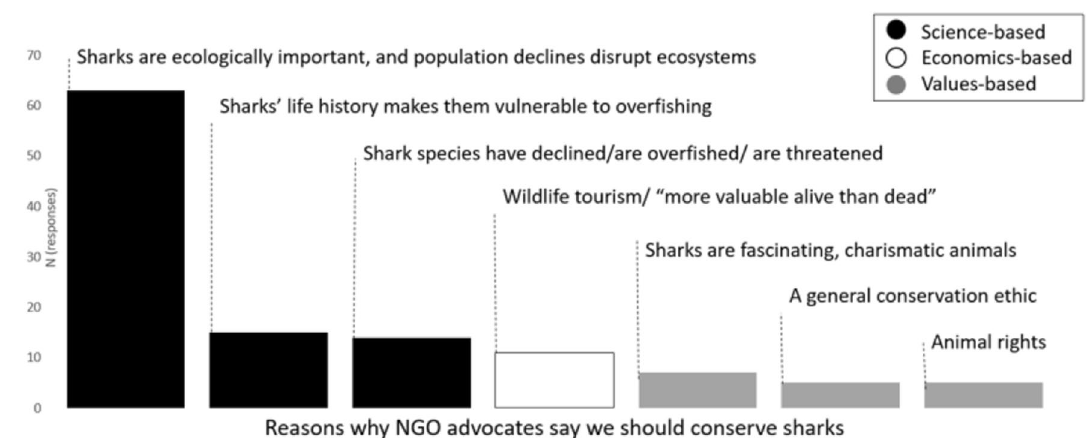
Figure 2. Categorized responses to the question “What arguments does your NGO make to conserve sharks,” with science-based, economics-based, or emotional arguments as possible